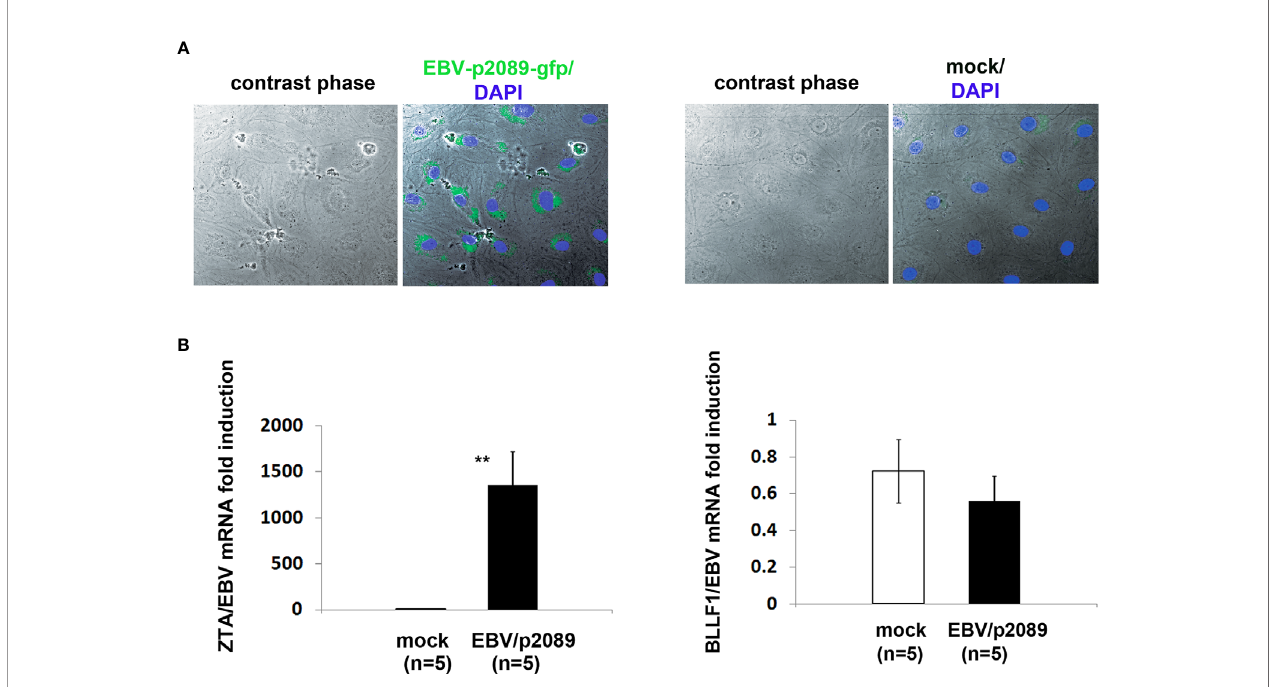
FIGURE 5 | EBV/p2089 infection of human dermal microvascular endothelial cells in vitro. Monocytes from healthy donors previously exposed to EBV-p2089 were co-cultured with human dermal microvascular endothelial cells (HDMECs) grown on collagen-coated chamber slides. In parallel, mock infected cultures were established by co-culturing HDMECs with monocytes not exposed to EBV-p2089. After 48h monocytes and EBV-p2089 free virus were removed from endothelial cells. (A) One representative of fi ve experiments. Immuno fl uorescence staining of HDMECs infected with EBV-p2089. Cells were fi xed with 100% acetone and mounted using Vectashield mounting medium with DAPI. EBV-p2089-GFP in endothelial cell cultures was detected using a FluoView FV10i confocal microscope system at 488 (green) and 405 nm (blue). Original magni fi cation 600x. (B) Expression of EBV lytic genes by qPCR in EBV-p2089 infected endothelial cells. Data are expressed as the fold-change normalized to mRNA expression in a single sample of mock infection. Bars represent mean ± S.E.M.